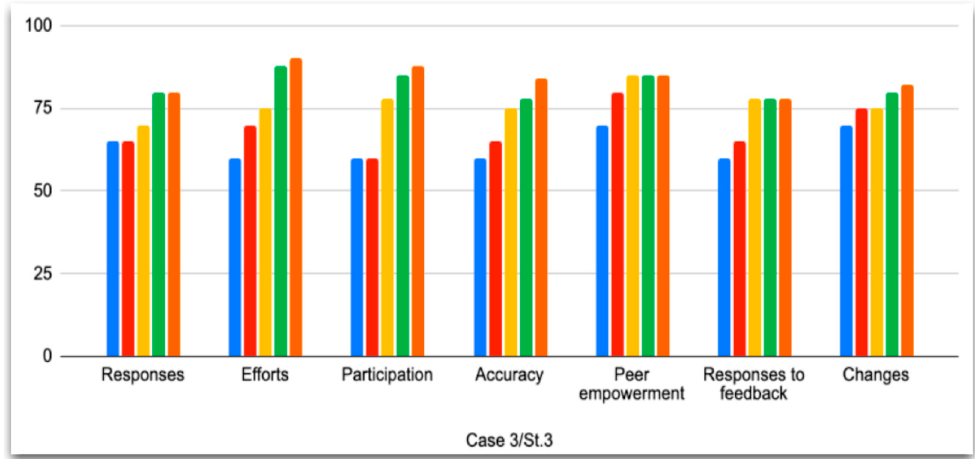
Figure 3. Vocabulary and spelling progress during alternative assessment online/Case 3.